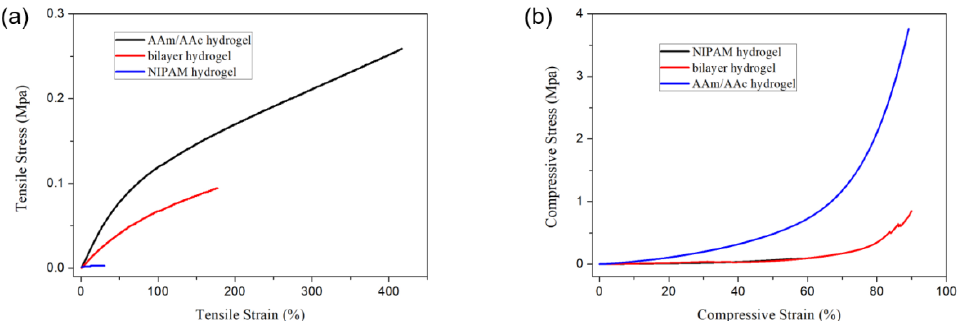
Figure 8. ( a ) Tensile stress − strain curves and ( b ) compressive stress − strain curves of the AAm/AAc Figure 8. (a) Tensile stress−strain curves and (b) compressive stress−strain curves of the A Am/AAc hydrogel, NIPAM hydrogel, and bilayer hydrogel at room temperature. hydrogel, NIPAM hydrogel, and bilayer hydrogel at room